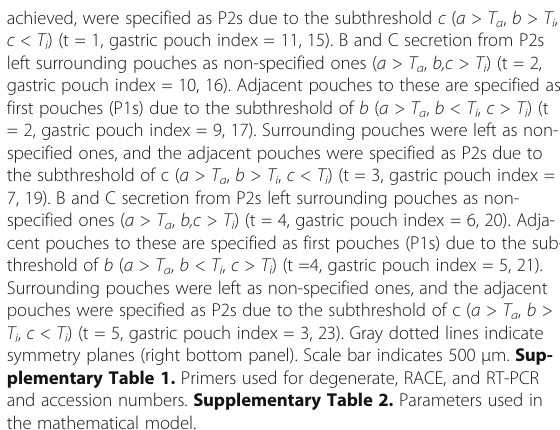
plementary Table 1. Primers used for degenerate, RACE, and RT-PCR and accession numbers. Supplementary Table 2. Parameters used in the mathematical